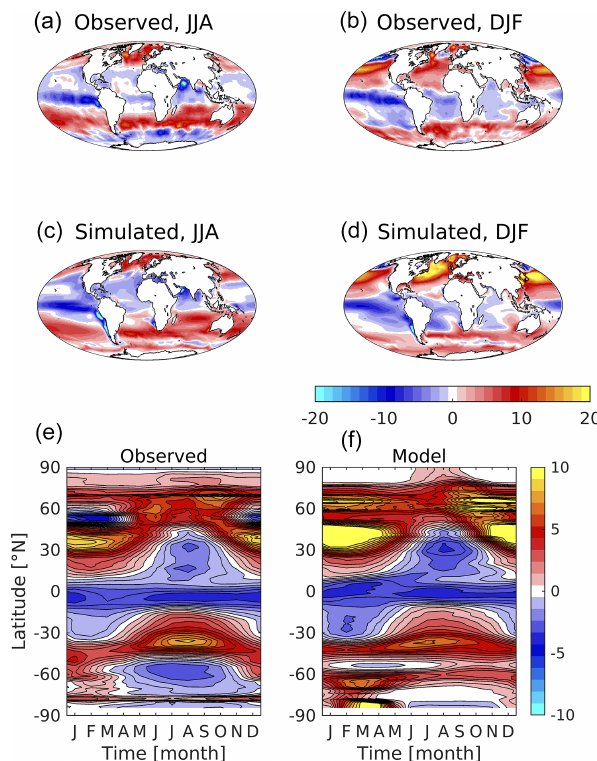
Figure 16. Observed ( a, b ; Rödenbeck et al., 2013) and simu- lated (c, d) air–sea CO 2 flux shown geographically for northern ( a, c ; JJA) and southern summer ( b, d ; DJF), and as zonal Hov- möller diagrams (e, f) . Red colours indicate CO 2 flux into the ocean, while blue colours denote outgassing CO 2 . Flux is given in mmolCm − 2 d − 1